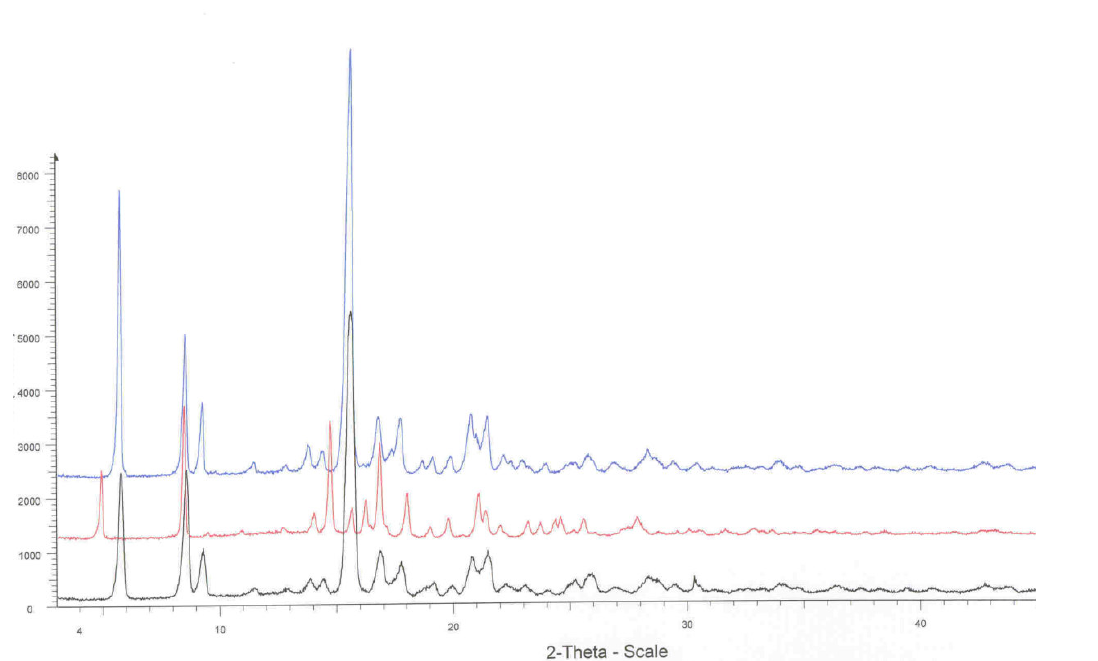
Figure 1. X-ray powder diffraction (XRPD) pattern of 1 as a -form (A), included with DMSO (B) and after removal of the DMSO included guest